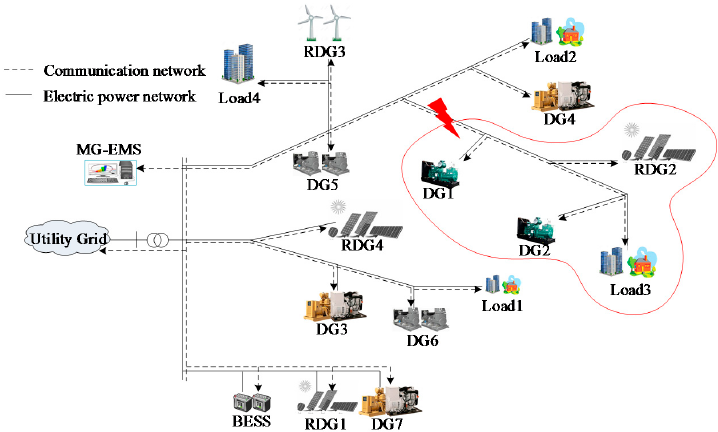
Figure 15. Case 2: Simulated scenario for evaluating proposed strategy during emergency mode operation.